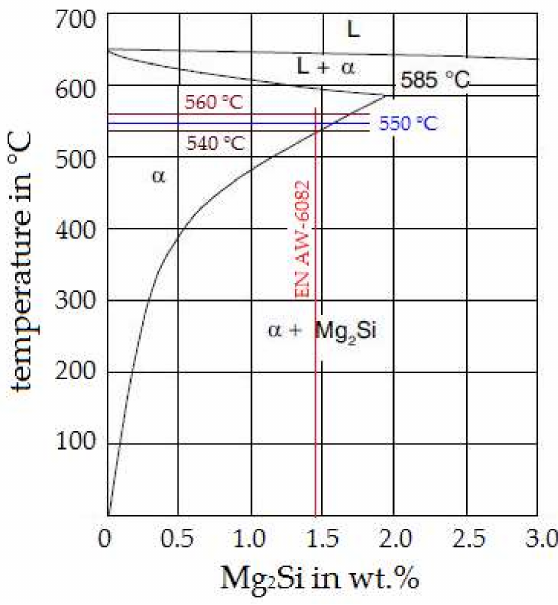
Figure 6. Section from the quasi-binary phase diagram Al-Mg 2 Si (adopted from Polmear [1]). The theoretical maximum amount of β -Mg 2 Si in this batch of EN AW-6082 (vertical red line), as well as the applied solution temperatures (horizontal lines), is